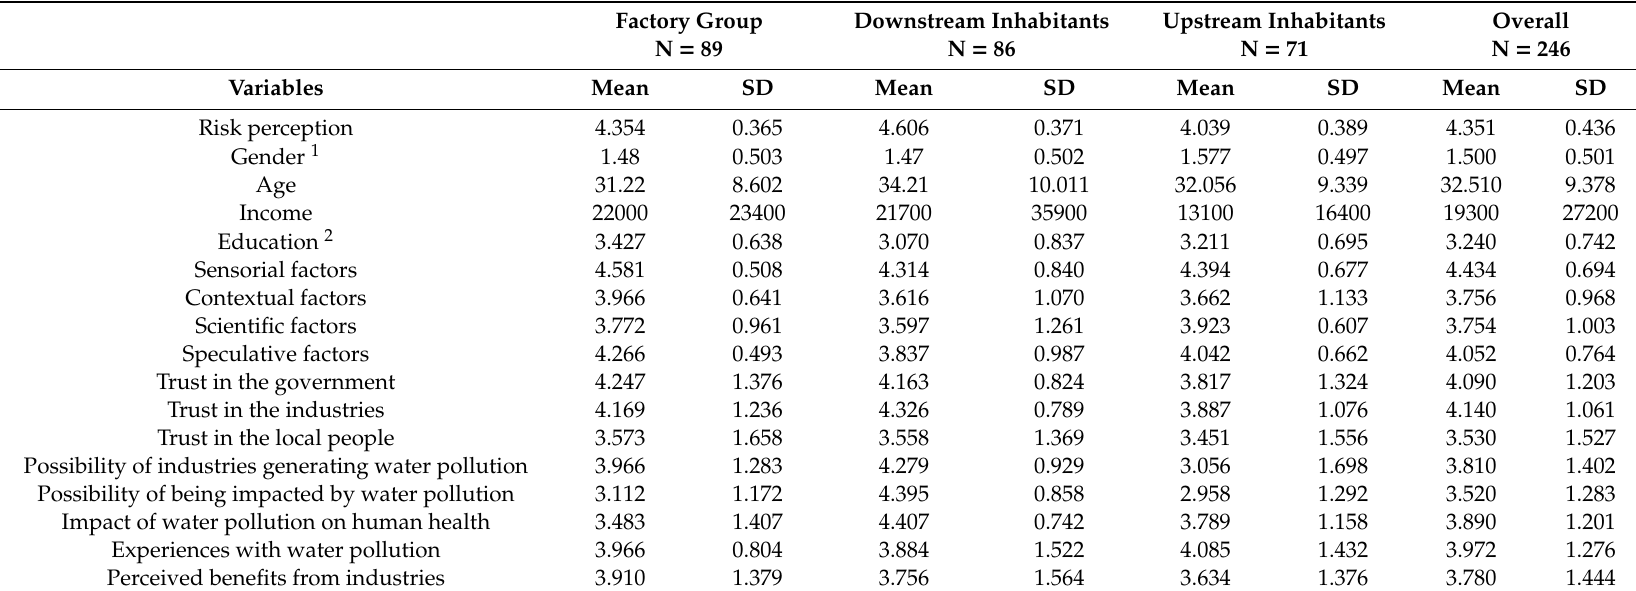
Table 3. Mean scores and standard deviations of risk perception and influencing